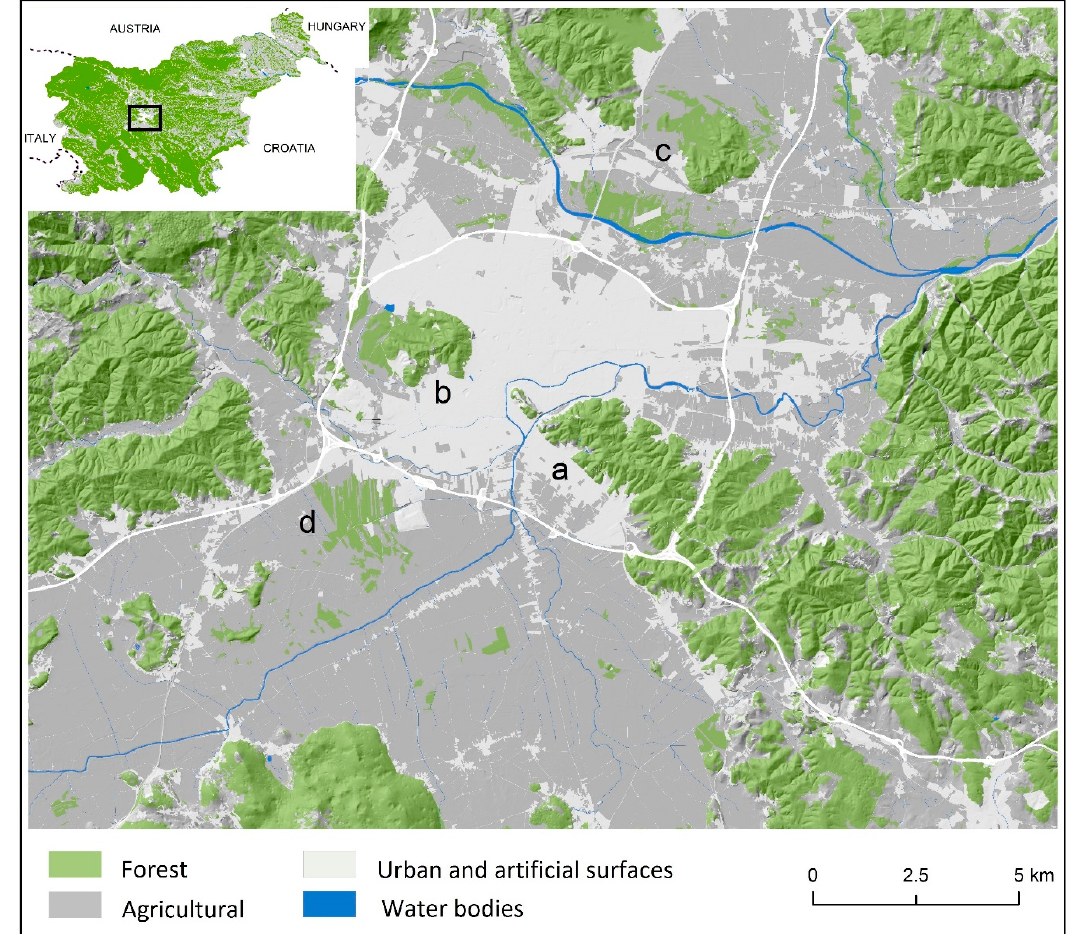
Figure 1. The wide study area of Ljubljana with the marked positions of four forest patches on the outskirts of the city. ( a ) Golovec (east); ( b ) Rožnik (west); ( c ) Nadgorica (north); and ( d ) Barje (south).